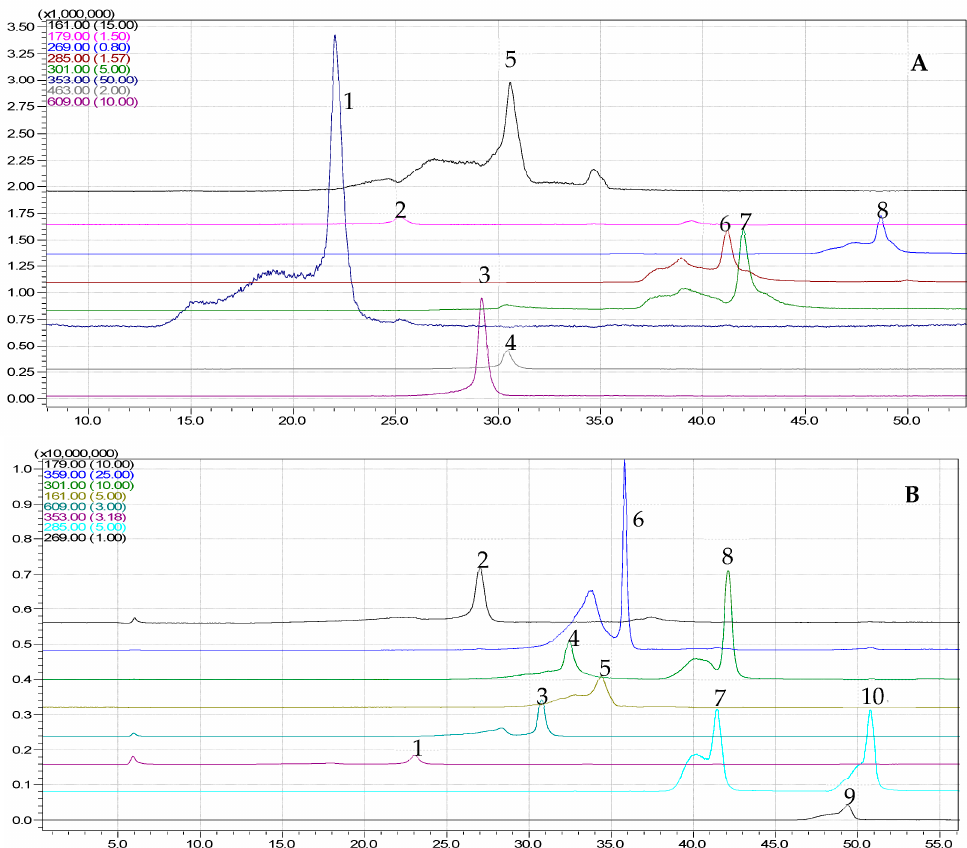
Figure 1. Chromatograms obtained for A. abrotanum polyphenolic compound-rich extract ( A ) and S. officinale polyphenolic compound-rich extract ( B ) by HPLC-MS (A, 1-chlorogenic acid, 2-caffeic acid, 3-rutin, 4-quercetin 3- β -D-glucoside, 5-umbelliferone, 6-luteolin, 7-quercetin, 8-apigenin peaks, respectively, B, 1-chlorogenic acid, 2- caffeic acid, 3-rutin, 4-ellagic acid, 5-umbelliferone, 6- rosmarinic acid, 7-luteolin, 8-quercetin, 9- apigenin, and 10-kaempferol peaks).